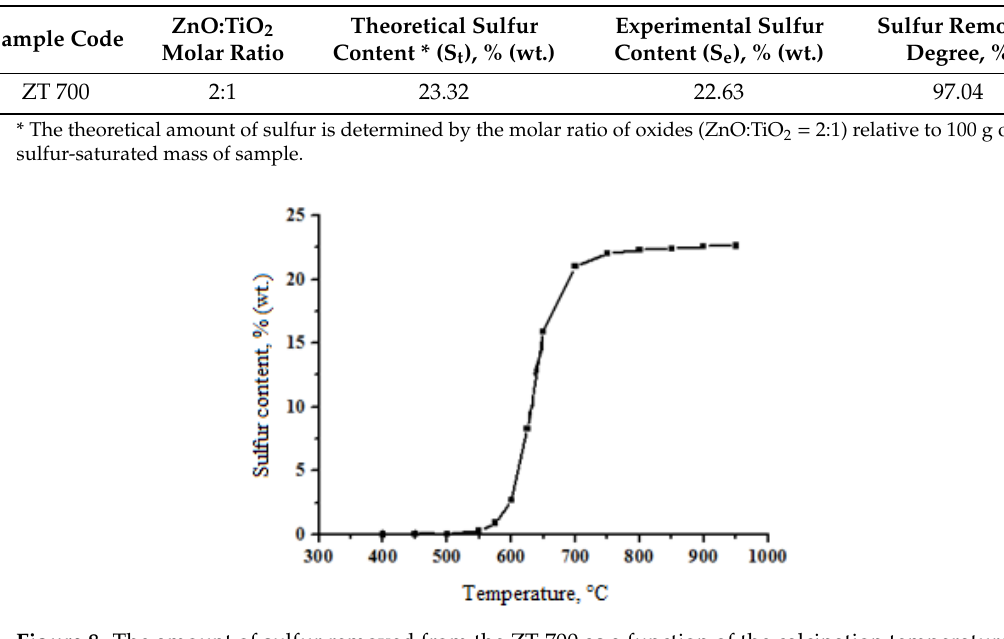
Table 2. Sulfur content and the degree of ZnO consumption in the sample.